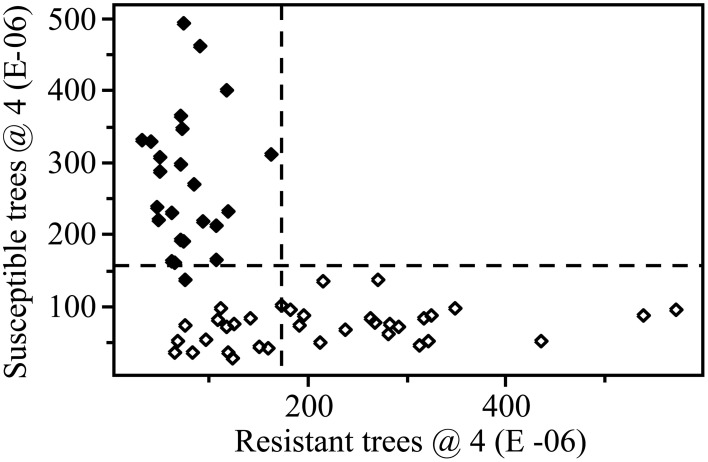
SIMCA Coomans plot with 4 factors (dashed lines indicate critical sample residual thresholds) based on transformed (SNV and second derivative) data. Data from the Excalibur 3500GX (benchtop) unit equipped with triple-bounce ATR accessory. Closed diamonds—resistant trees; open diamonds—susceptible trees. This plot shows the relative, dimension-free distance of a sample from a given class, resistant (x-axis) or susceptible (y-axis), based on the 4 factor SIMCA analysis.